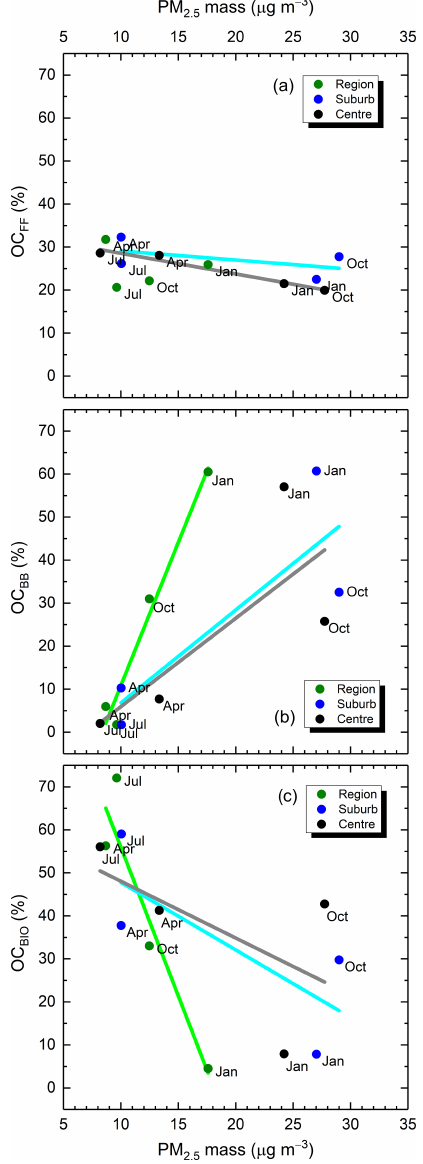
Figure 8. Monthly mean contribution of apportioned OC FF (a) , OC BB (b) and OC BIO (c) to TC as a function of the monthly median PM 2 . 5 mass concentration (surrogate or proximity value for the air quality) for regional background in the Carpathian Basin, suburban area and city centre of Budapest. The months are marked by their starting letters. The fitted linear lines are just to guide the